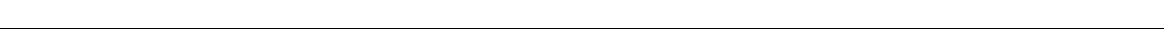
Fig. 7 Glutaminolysis is not important for sustaining OXPHOS in cytokine-activated NK cells. a – d NK cells were stimulated with IL-2/IL-12 for 18 h and